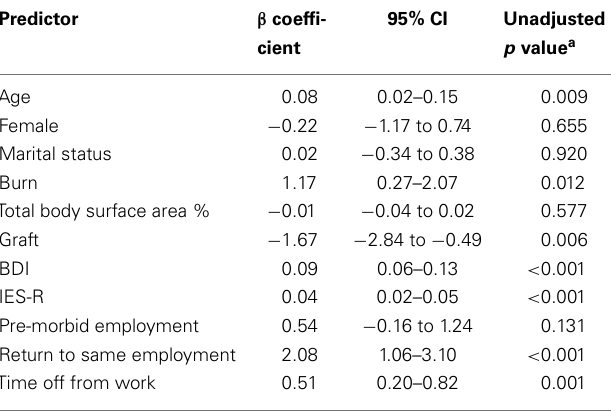
Table 3 | Univariate analysis of pain outcome with multiple covariates